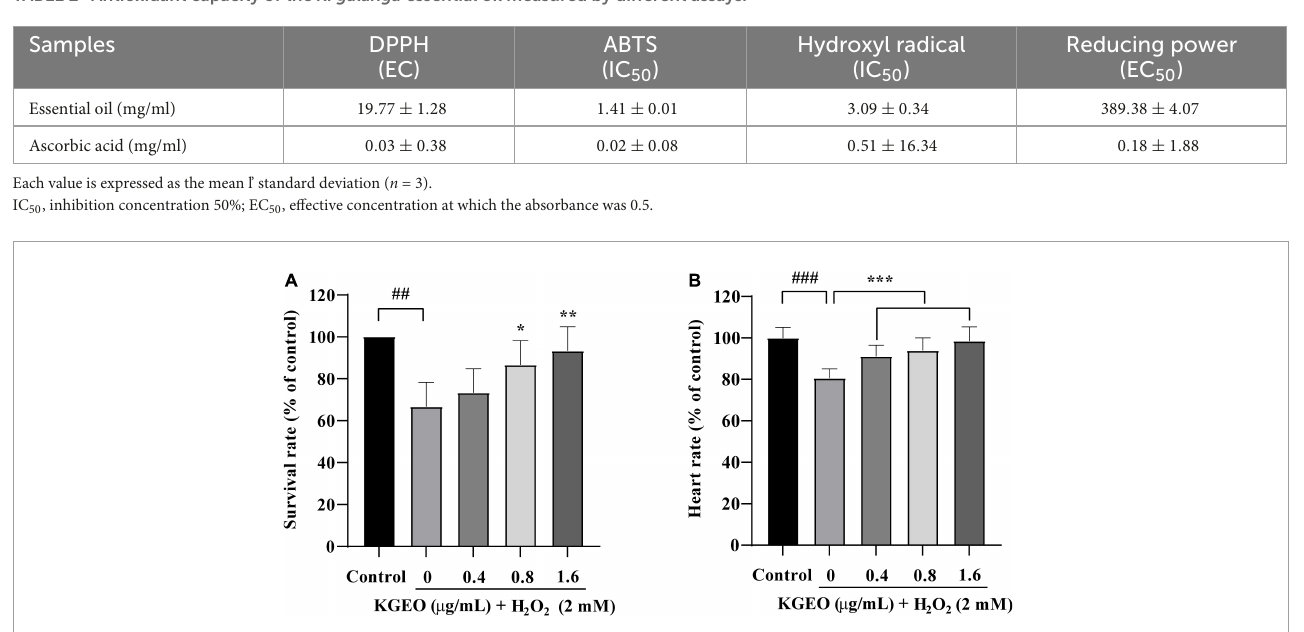
FIGURE1 Survival rate and heartbeat rate of H 2 O 2 -induced zebrafish treated with Kaempferia galanga essential oil (KGEO). The survival rate (A) and the heartbeat (B) of zebrafish. The results are expressed as mean ± SD ( n = 15). ## P < 0.01, ### P < 0.001 as compared to the control group. * P < 0.05, ** P < 0.01, *** P < 0.001 as compared to the H 2 O 2 -treated